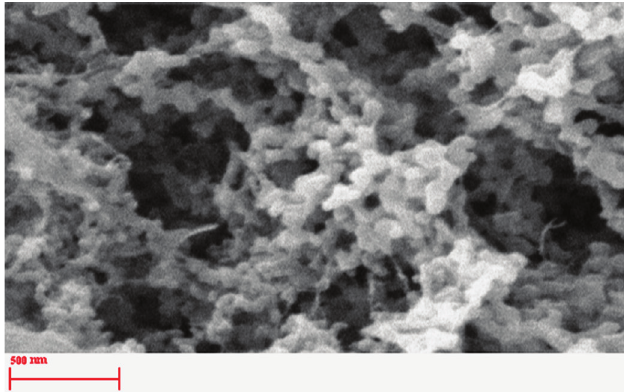
FIGURE 4 - SEM image of flutamide